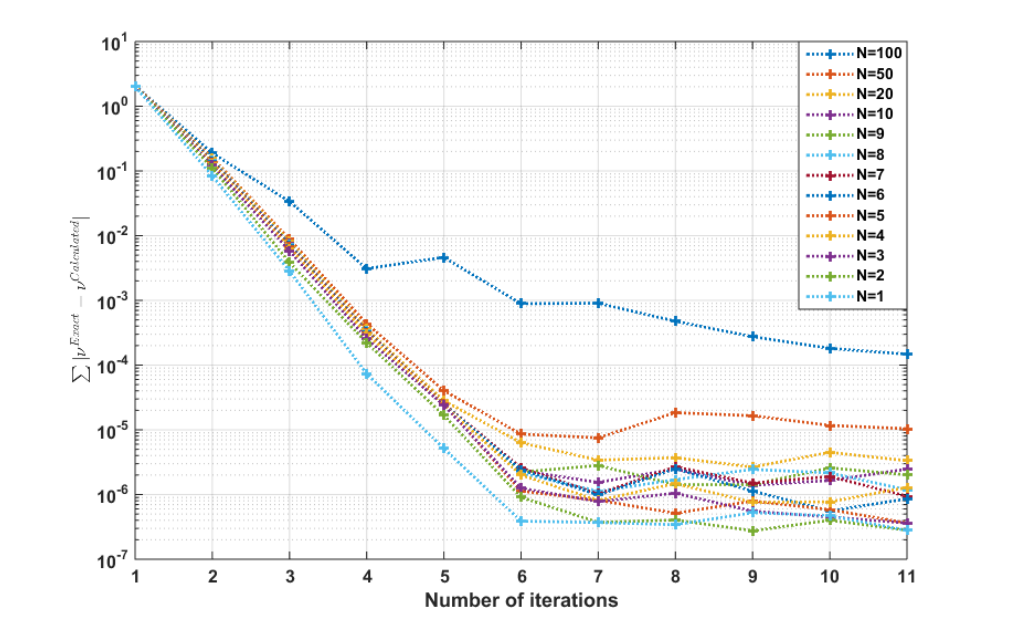
Figure 7. Sum of the absolute errors in the reconstructed eigenvalues: ∑ | ν Exact − ν Calculated | using the Magnus method vs. the iteration number, using eigenvalue sets of sizes N = 1, . . . ,10,20,50,100 for reconstructing the potential q ( x ) = cos ( π x )